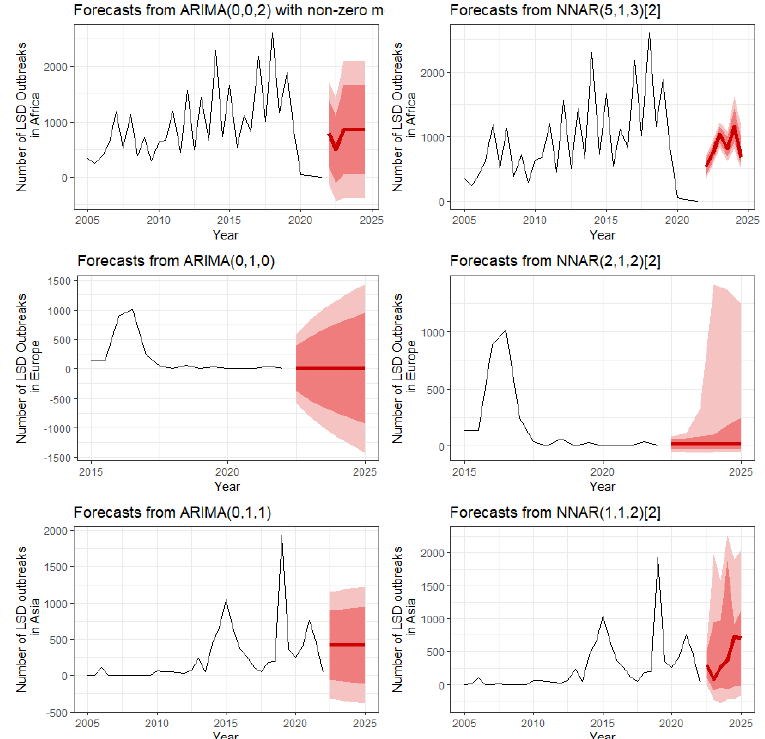
Figure 8 . Number of LSD outbreaks in Africa, Europe, and Asia forecasted by ARIMA and NNAR. The thick red line represents point forecasts of LSD outbreak reports; the dark and light shades indicate 95% and 80% confidence intervals, respectively.